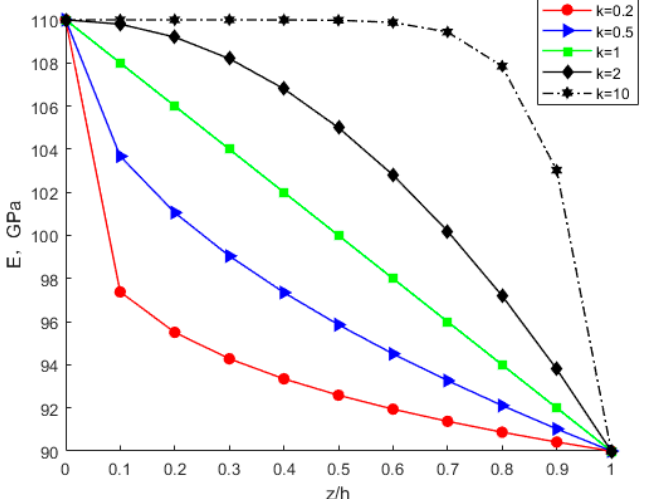
Figure 10. Variation in Young’s modulus through the thickness direction of the FGM plate.